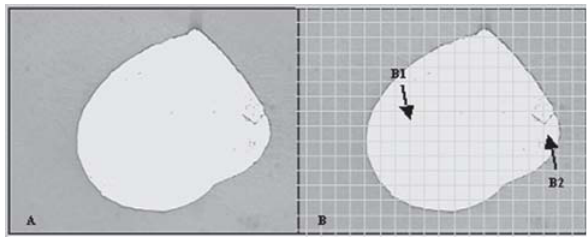
FIGURE 1- Microscopic image (X40) of the apical third. B. The same image with the grid; Arrows indicate areas without (B1) and with debris